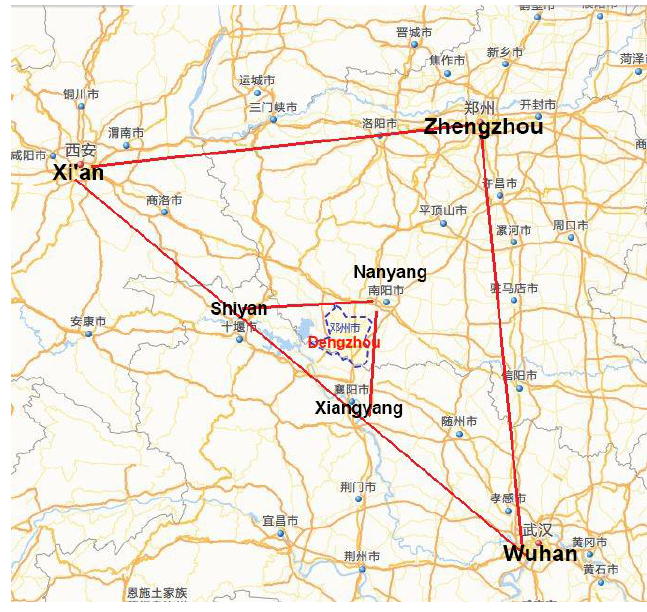
Figure 4. Geographic location map of Dengzhou city.